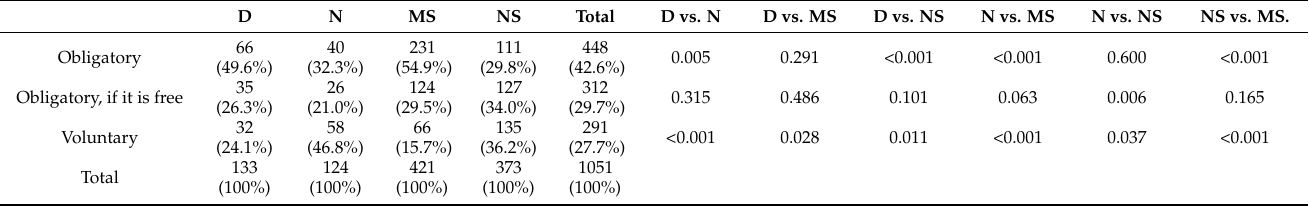
Table 9. Attitudes towards obligatory annual vaccination against COVID-19 in four groups of vaccinated healthcare